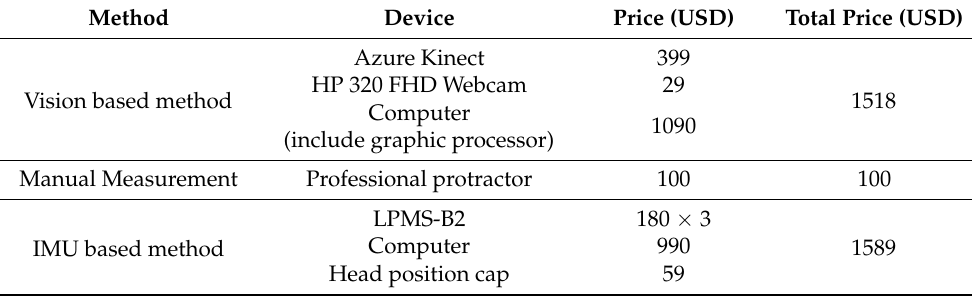
Table 6. The costs of implementation and maintenance of the methods.